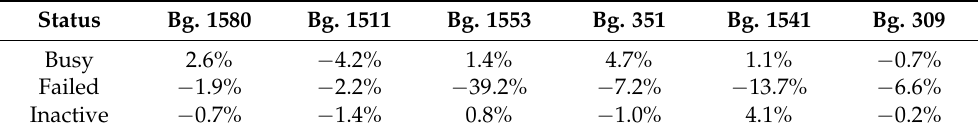
Table 9. Differences between the actual and model utilization.